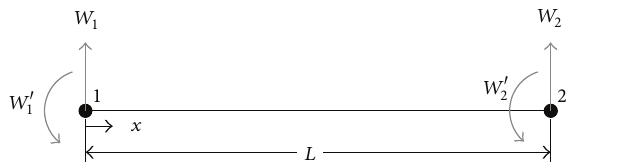
Figure 3: A 2-node, 4-degree-of-freedom (4-DOF) beam element.